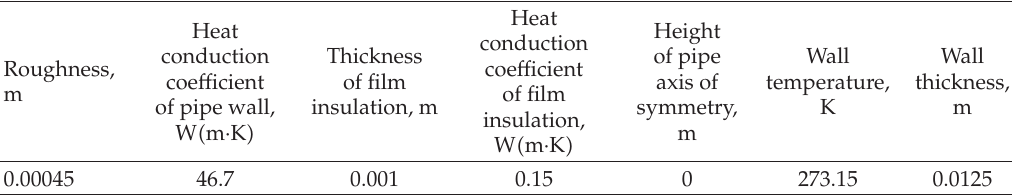
Table 1: Pipe parameters in test.